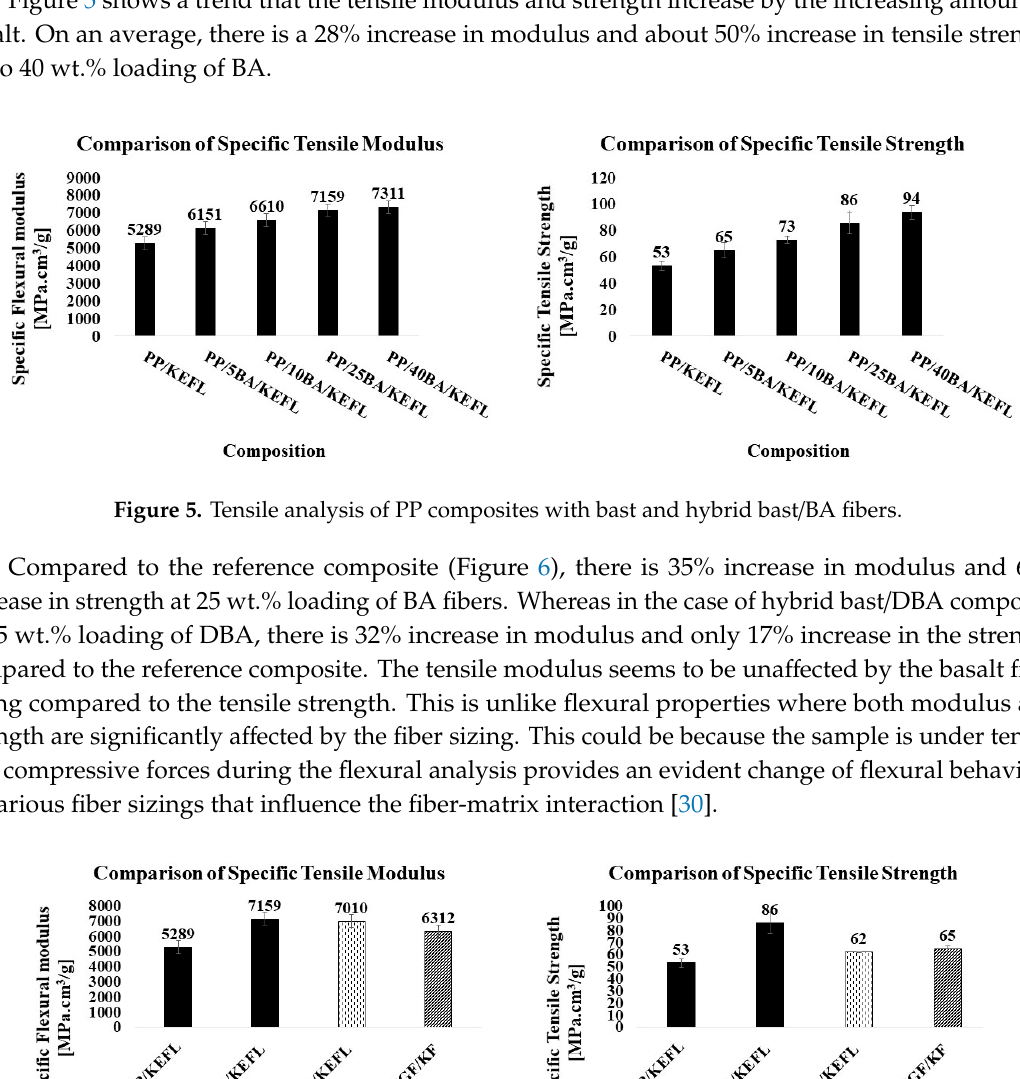
Table 4. Tensile analysis and density of the composites.